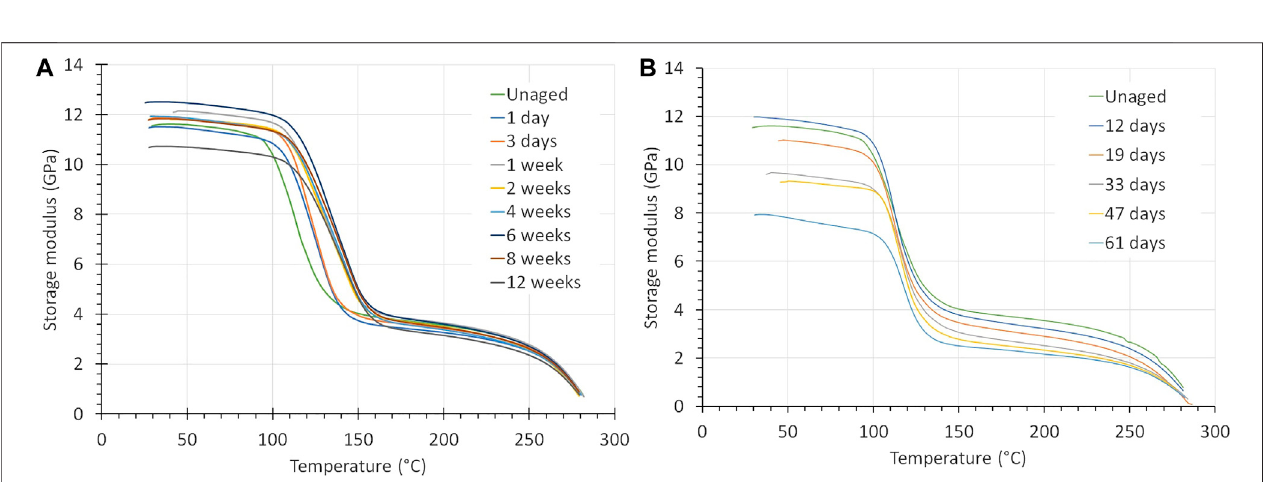
FIGURE 6 | The 1 Hz modulus curves of PPS-40%gf exposed to (A) 5 bar O 2 at 120 ° C and (B) a 30 wt% KOH solution at 90 ° C, which exhibits a big drop in the modulus below T g